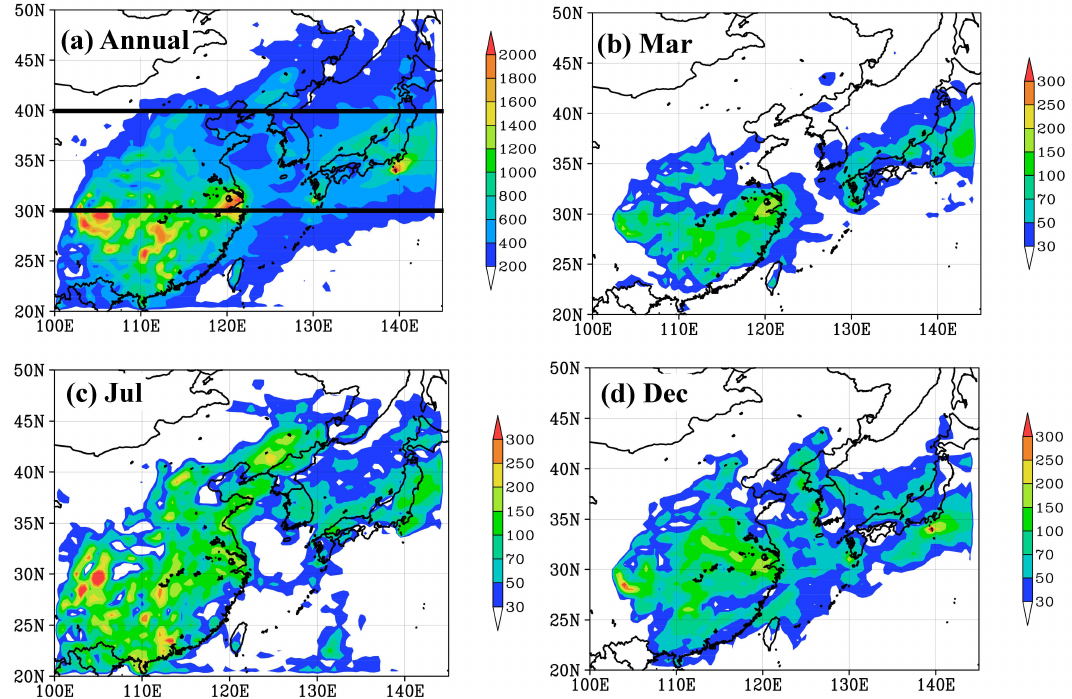
Fig. 4. Same as Fig. 3 but for the wet deposition of total S (mgSm − 2